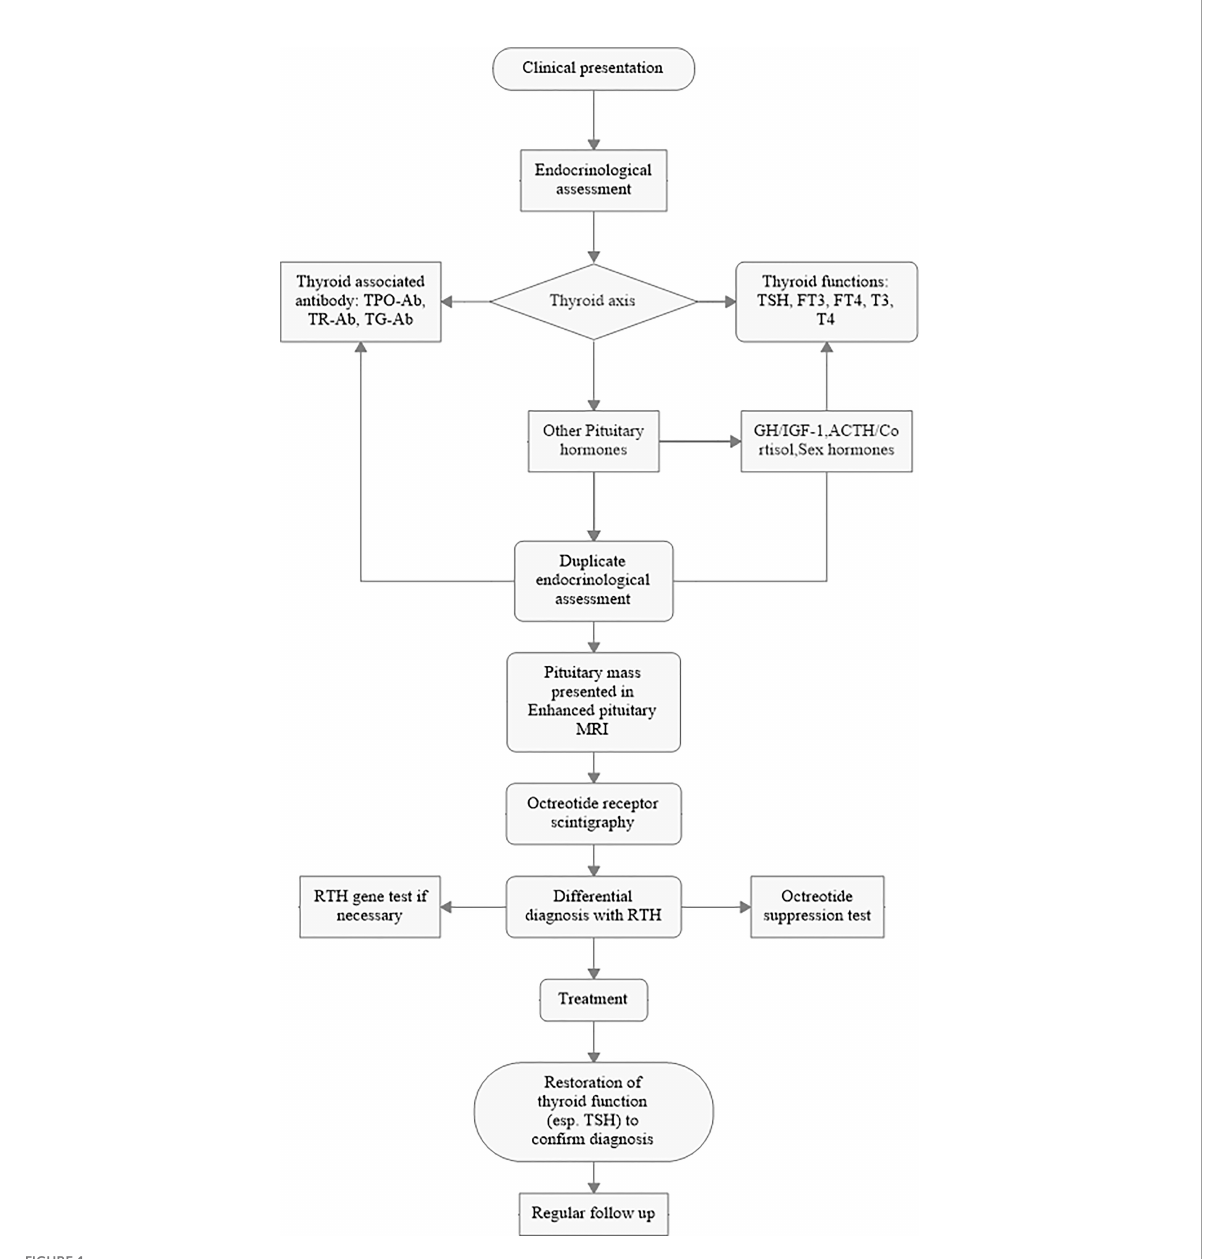
FIGURE 1 Work fl ow of diagnosis for